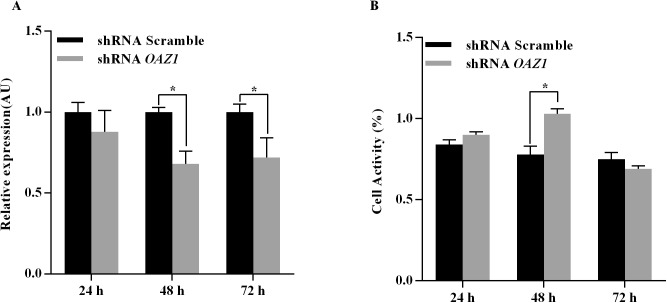
Characteristics of granulosa cells in geese 24 h, 48 h and 72 h after shRNA OAZ1 transfection.A: The OAZ1 mRNA expression level in granulosa cells. B: The activity of granulosa cells.